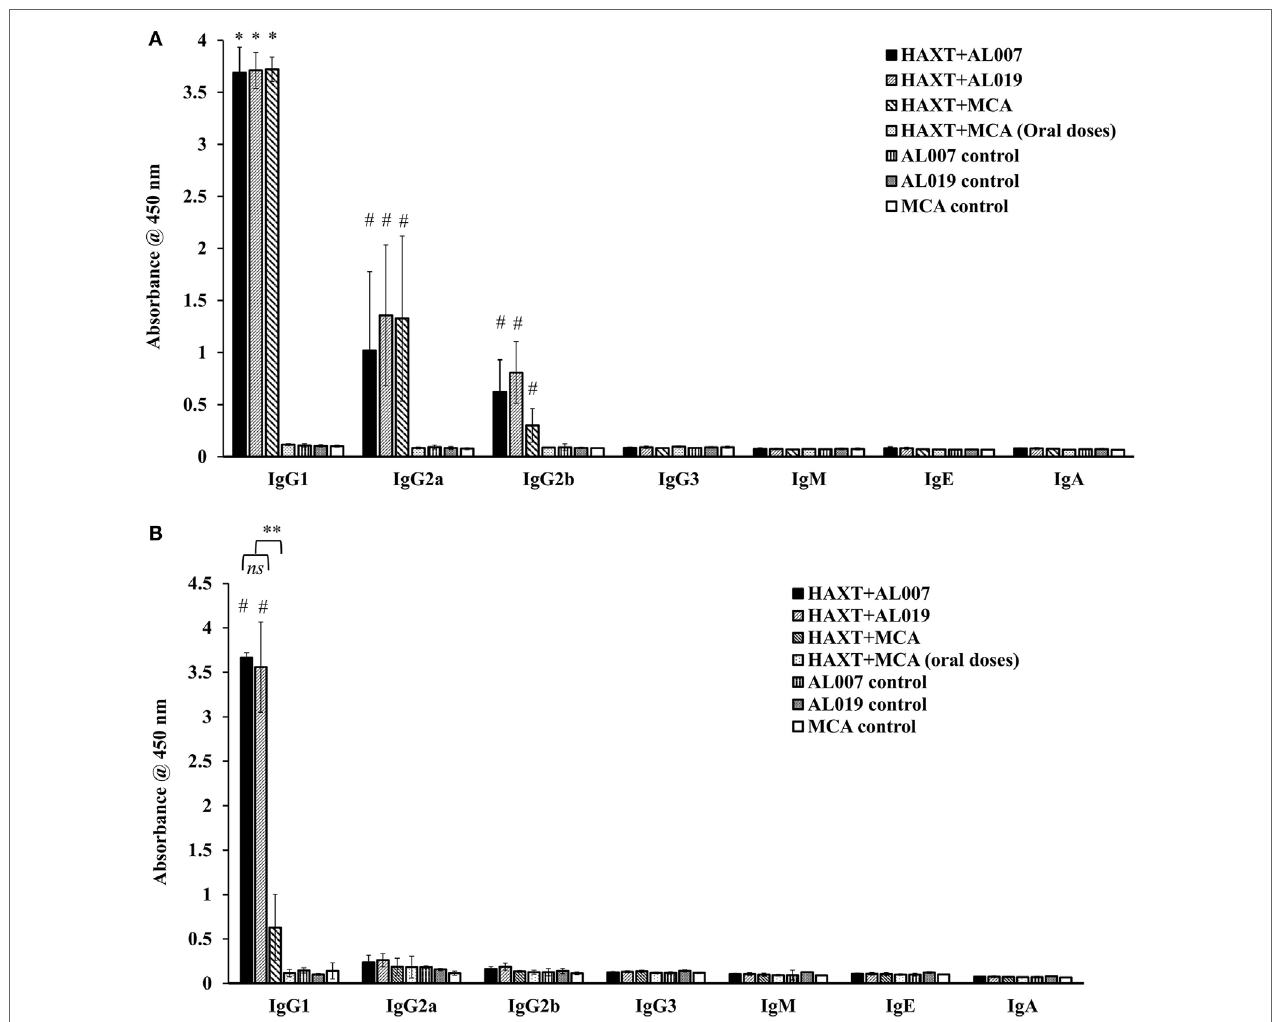
FigUre 3 | Level of antigen-specific antibody isotypes was determined by indirect ELISA in sera samples as well as in peritoneal fluid. (a) IgG1 was found predominant in all the immunized animals when compared to their respective adjuvant control groups. Specifically, IgG2a was found to be increased in r Bm HAXT + AL019 and r Bm HAXT + mannosylated chitosan (MCA) groups compared to the r Bm HAXT + AL007 group. IgG2b antibody level was significantly increased in r Bm HAXT + AL019 immunized group (B) IgG1 is much lesser in the peritoneal fluid of r Bm HAXT + MCA (s/c) group when compared to r Bm HAXT + AL007 and r Bm HAXT + AL019 groups. Moreover, IgG2a and IgG2b antibodies were not detected in peritoneal fluid of all the group of animals as observed in the sera of vaccinated animals. n = 5 per group, * p < 0.05, # p < 0.001 compared to respective control group. ** p < 0.001 compared to r Bm HAXT + MCA group. ns = not significant, as analyzed by Kruskal- Wallis test followed by Bonferroni correction for multiple